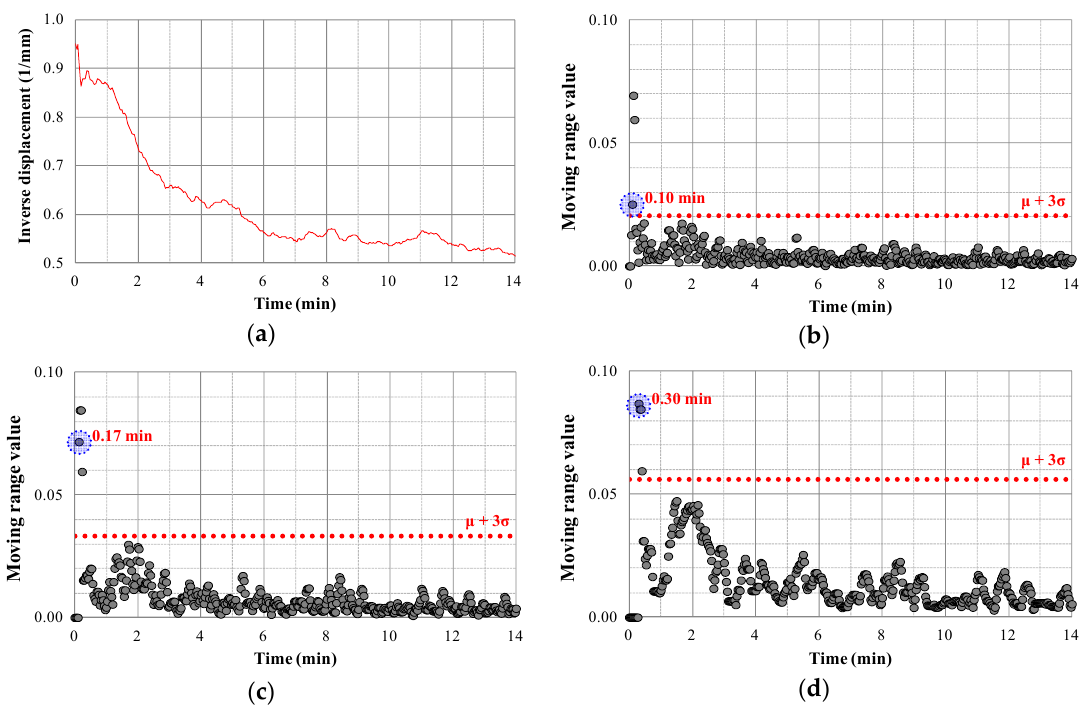
Figure 14. x–MR control chart for displacement data of case 2 (moving average = 30 points): ( a ) Inverse displacement (moving average = 30 points); ( b ) Moving range (K = 3); ( c ) Moving range (K = 5); ( d ) Moving range (K = 10).